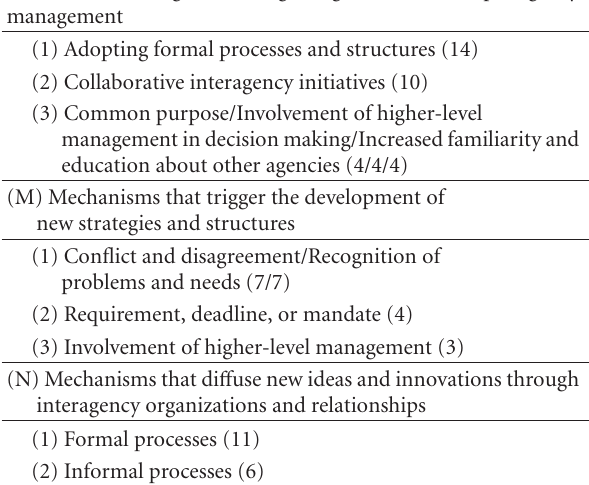
Table 6: Solutions for multiple-agency management: interviewee responses by conceptual category (L–N). Numbers in parentheses indicate number of responses from a total pool of 23